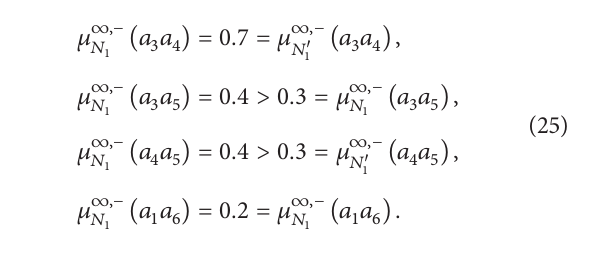
Then 𝑎 2 is a bipolar fuzzy 𝑁 1 - 𝑁 cut vertex